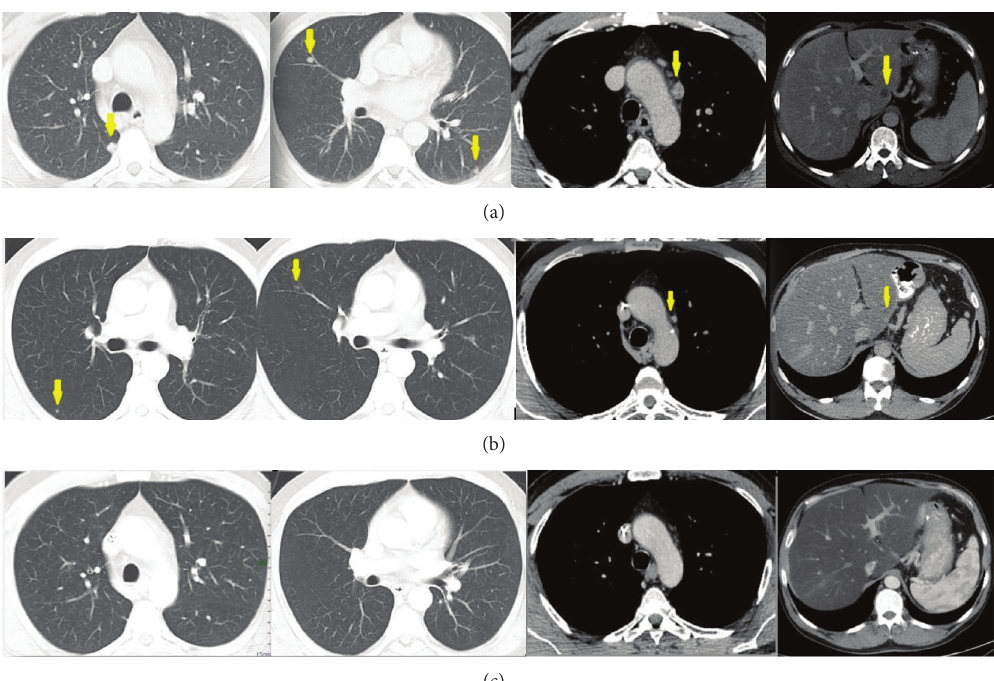
Figure 1: CT scan, axial images, at the same level, at the beginning of the therapy (a), after three cycles of chemotherapy (b) showing partial response (PR), and after the seventh cycle (c) in competence with complete response (CR). Yellow arrows indicate the pulmonary nodules (first two images) that are easily recognized at the first scan, are faintly differentiable at the following, and have disappeared at the final. In the remaining images, arrows indicate the pathologic mediastinal lymph node (third image) and the liver